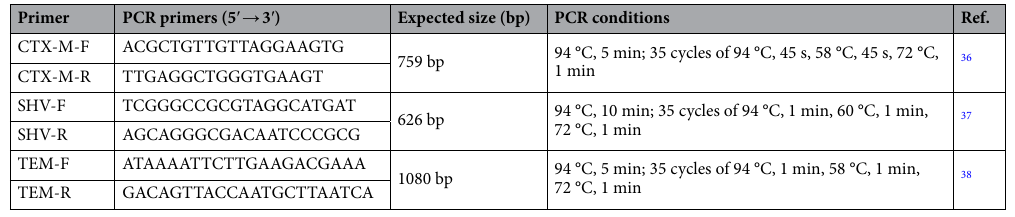
Table 1. Primers and conditions of